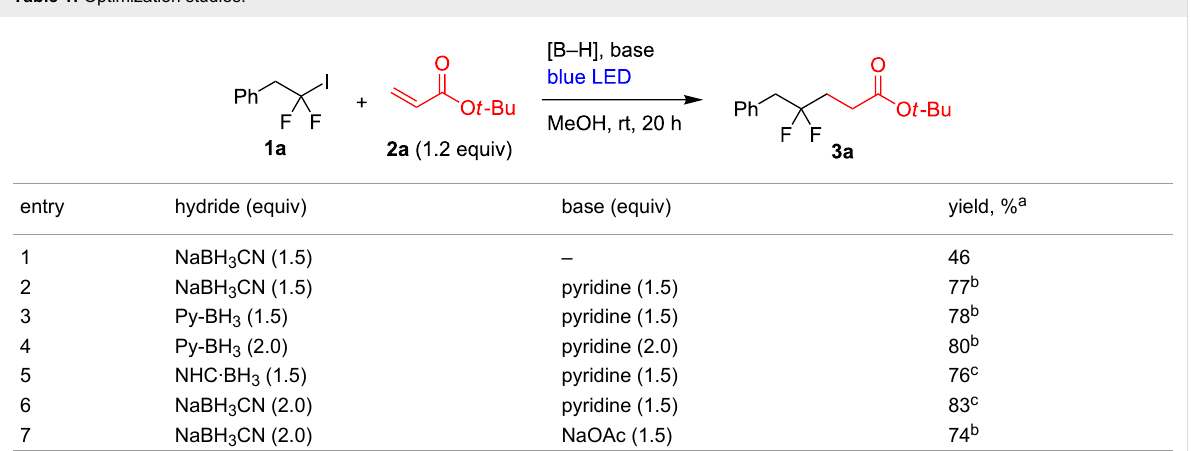
Table 1: Optimization